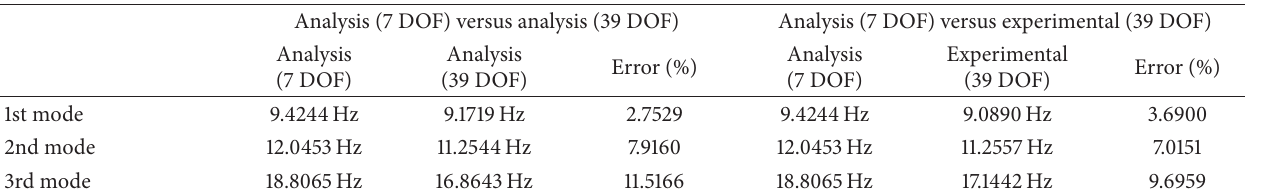
Table 8: Comparison of 7 DOF analysis results and full DOF cases.